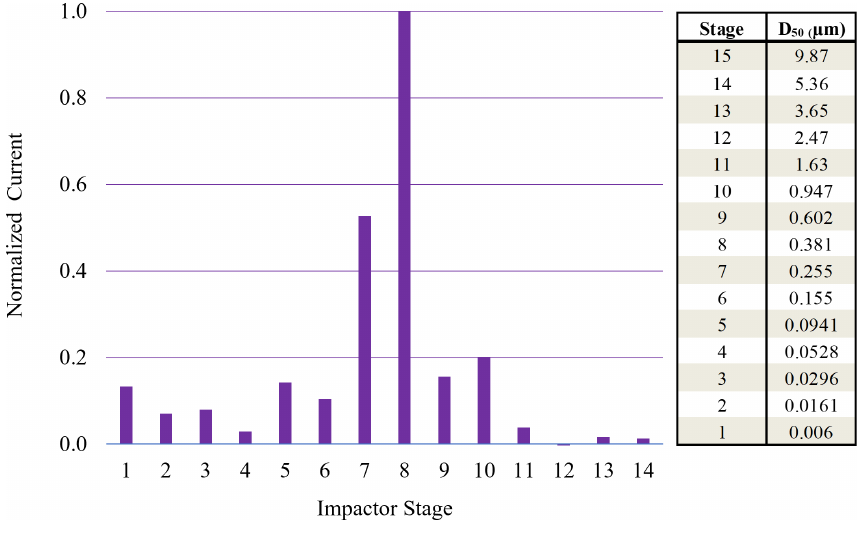
Figure 6. Normalized ELPI current values observed for each impaction stage for 190nm (initial dry diameter) sucrose particles sampled from 95% chamber